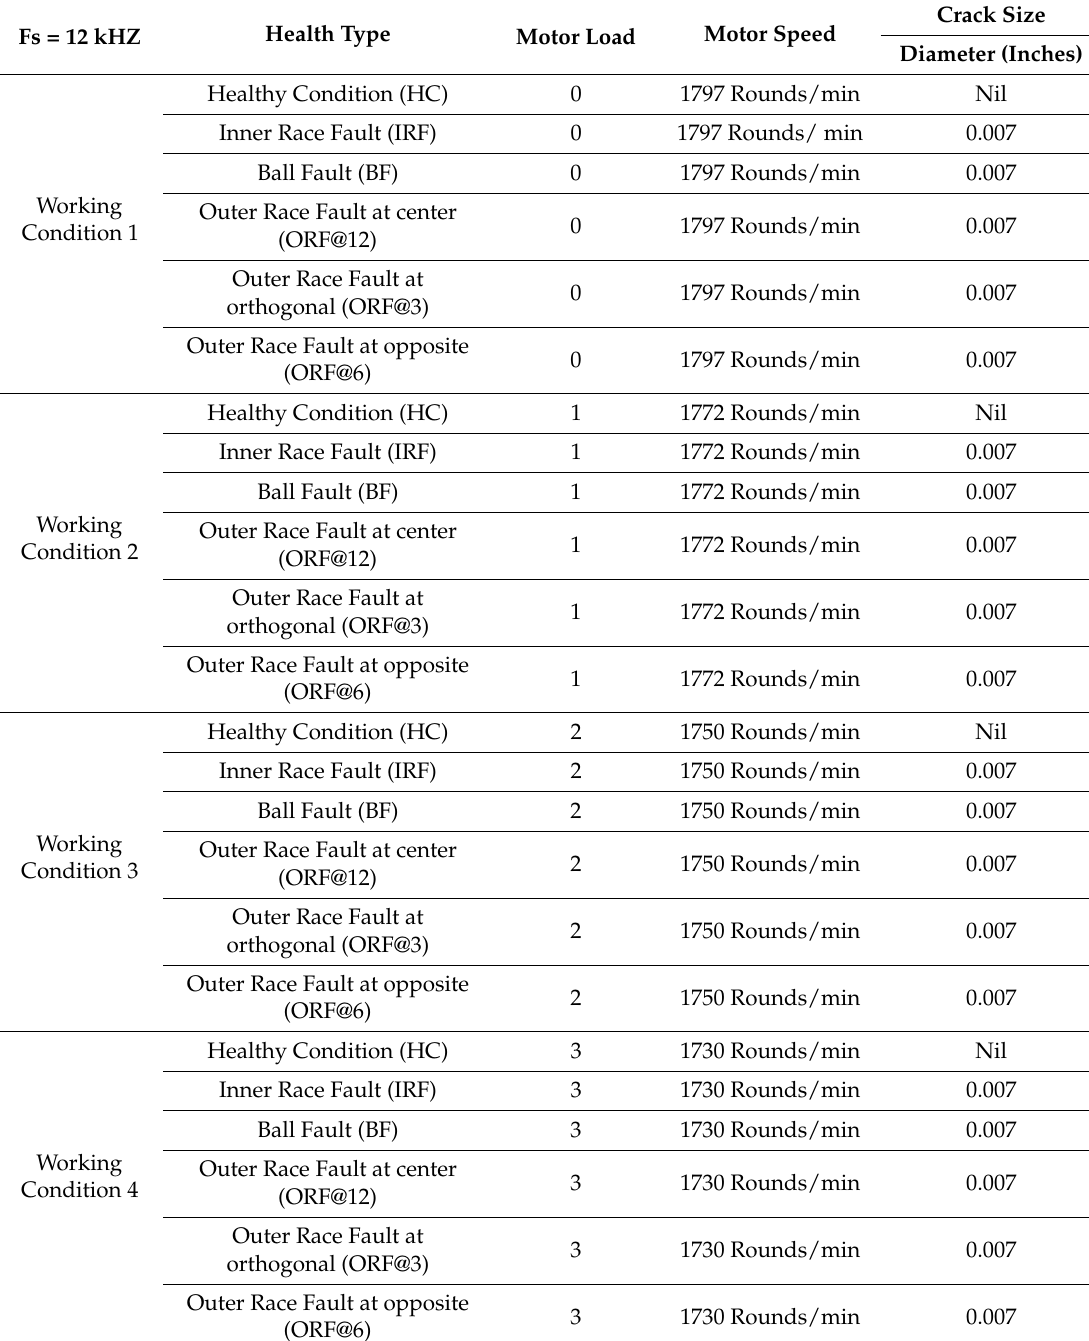
Table 2. Details of the considered working conditions with the same health